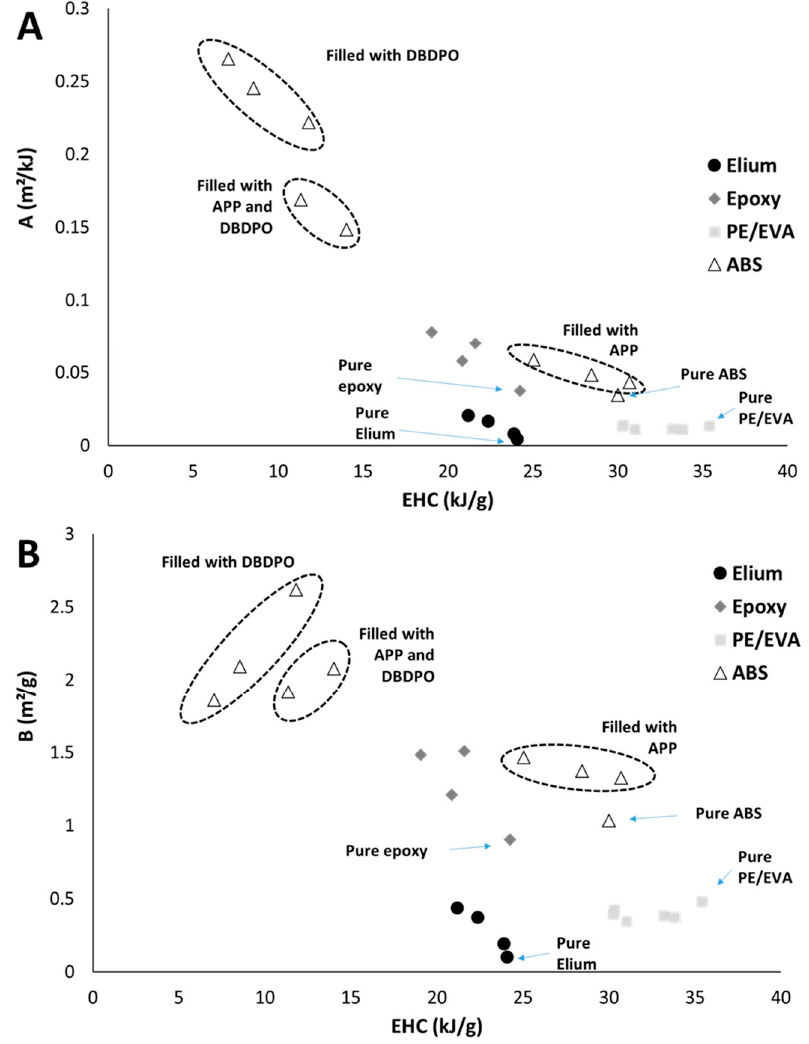
Figure 7. ( A )/A values versus EHC for several series of polymers filled with FR. ( B )/B values versus EHC for several series of polymers filled with FR.